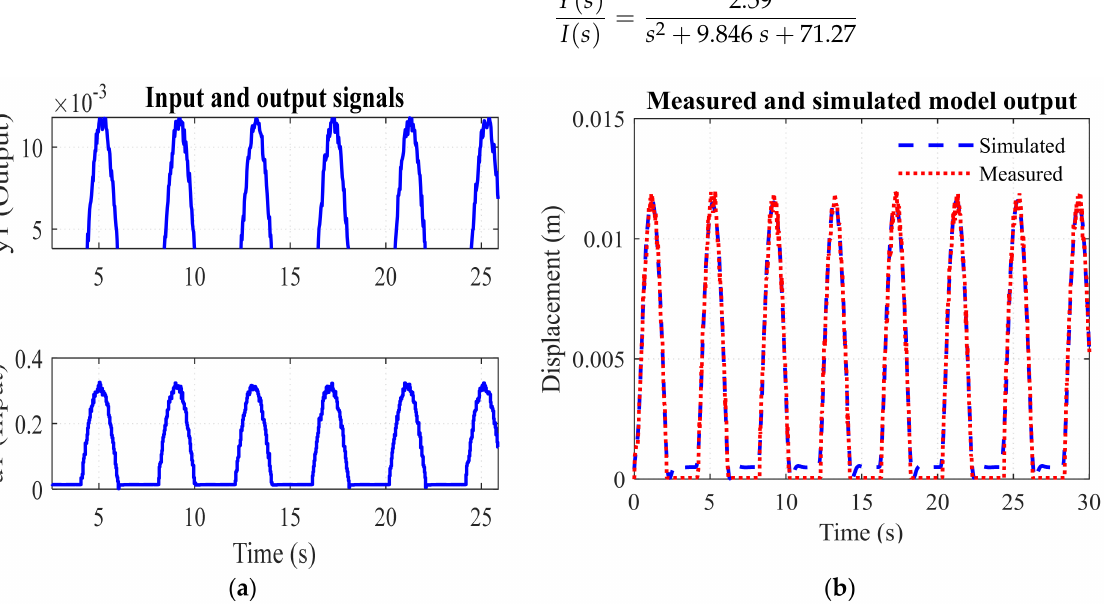
Figure 10. Signals associated with system identification: ( a ) input–output signals, ( b ) measured and simulated